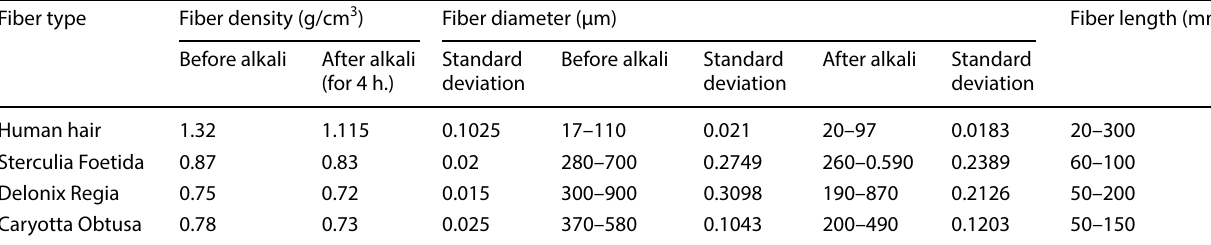
Table 1 Physical property of fibers Fiber